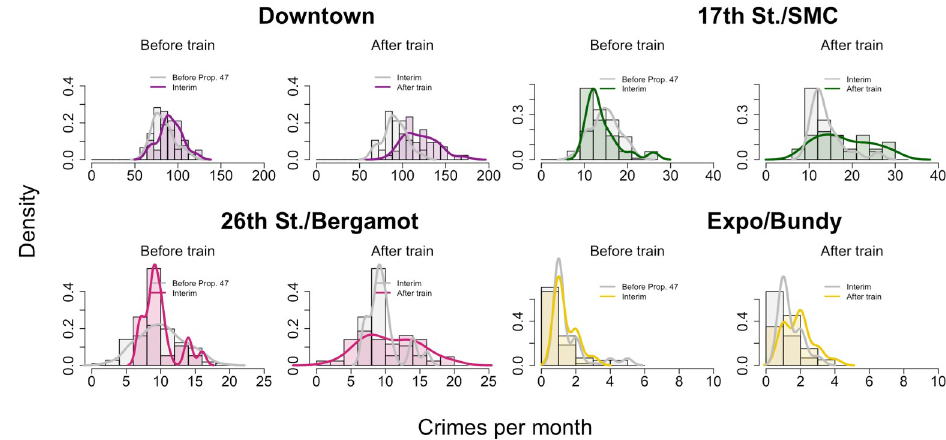
Fig 12. Reported crime near Expo Line light rail stations in Santa Monica, CA, during three successive time periods spanning 2006–2019. These normalized histograms (bars) and densities (curves) provide monthly reported crime counts in a 450 meter radius around locations at which new stations opened in 2016. The time periods are: (1) January, 2006—October, 2014, before implementation of Prop. 47; (2) November, 2014—May, 2016, between the implementation of Prop. 47 and the opening of the Expo Line; and (3) June, 2016—December, 2019, after the opening of the Expo Line. For each location, the left plot incorporates periods (1) and (2), and the right plot incorporates periods (2) and (3). Changes to the mean are not statistically significant prior to opening of the Expo Line (left plots) except for the Downtown station. After opening of the Expo Line (right plots), crimes increased significantly at the Downtown and 17 th Street/Santa Monica College stations. See Table 4.